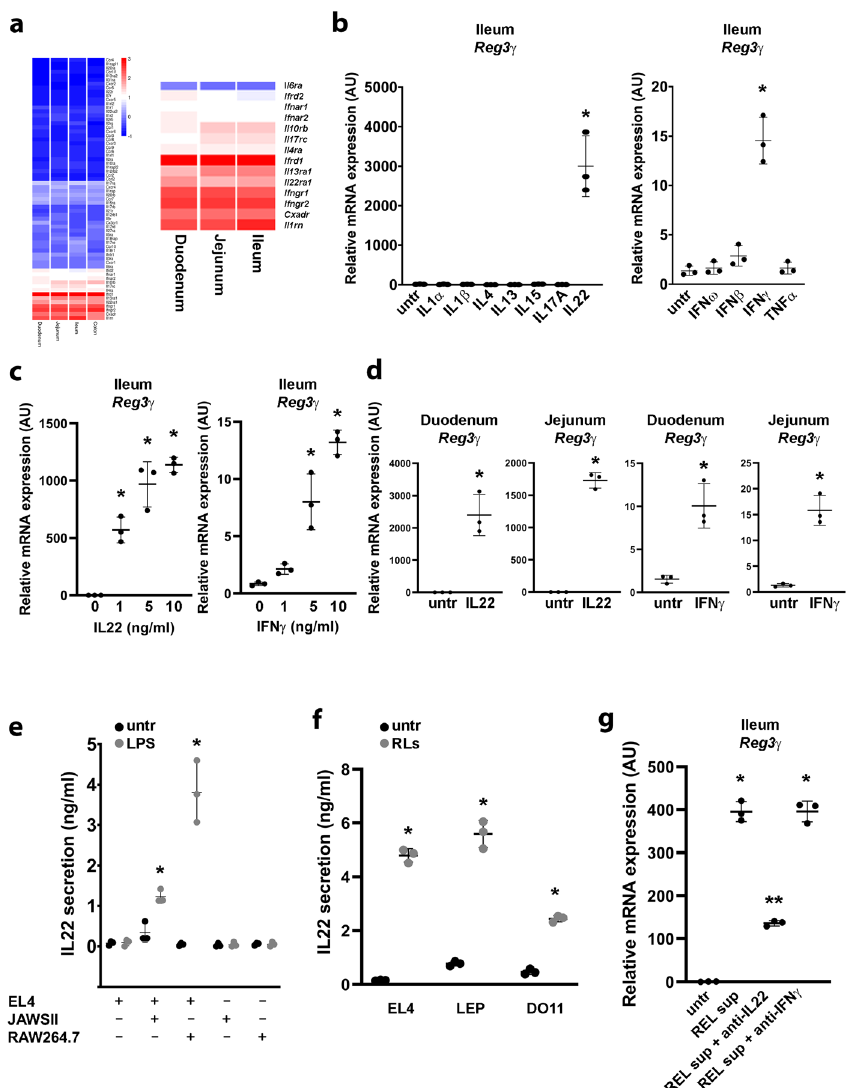
Fig. 2 Reg3 γ expression in intestinal organoids is induced by T cell-derived IL22 or IFN γ . a Cytokine receptor mRNA expression in duodenum, jejunum and ileum-derived organoids. b Reg3 γ mRNA expression in ileum-derived organoids after 24h exposure to cytokines (10 ng/ml). c IL22-induced and IFN γ - induced mRNA expression of Reg3 γ in ileum-derived organoids. d IL22- and IFN γ -induced mRNA expression of Reg3 γ in duodenum-derived or jejunum- derived organoids. e ELISA for IL22 on supernatants from EL4 T cells with prior exposure to supernatants from LPS-stimulated RAW264.7 or JAWSII cells. f ELISA for IL22 on supernatants from EL4, LEP, or DO11 T cells which were exposed to supernatants from LPS-stimulated RAW264.7 cells (RLs) for 48 h. g Reg3 γ mRNA expression in ileum-derived organoids after exposure of EL4-derived supernatants with prior exposure to LPS-treated RAW264.7 cell supernatant (REL) in the presence or absence of blocking antibodies for IL22 or IFN γ . All experiments were performed in triplicate with a minimum of three independent experiments. Data are shown as mean ± SD. For statistical analyses ( a – c , e , and g ), Log2 transformed data were used in Welch and Brown – Forsythe tests followed by Dunnett ’ s T3 multiple comparisons test. For comparison in d and f , we performed an unpaired t -test (two-tailed) with Welch ’ s correction on Log2 transformed data.* P < 0.05 was considered to indicate statistical signi fi